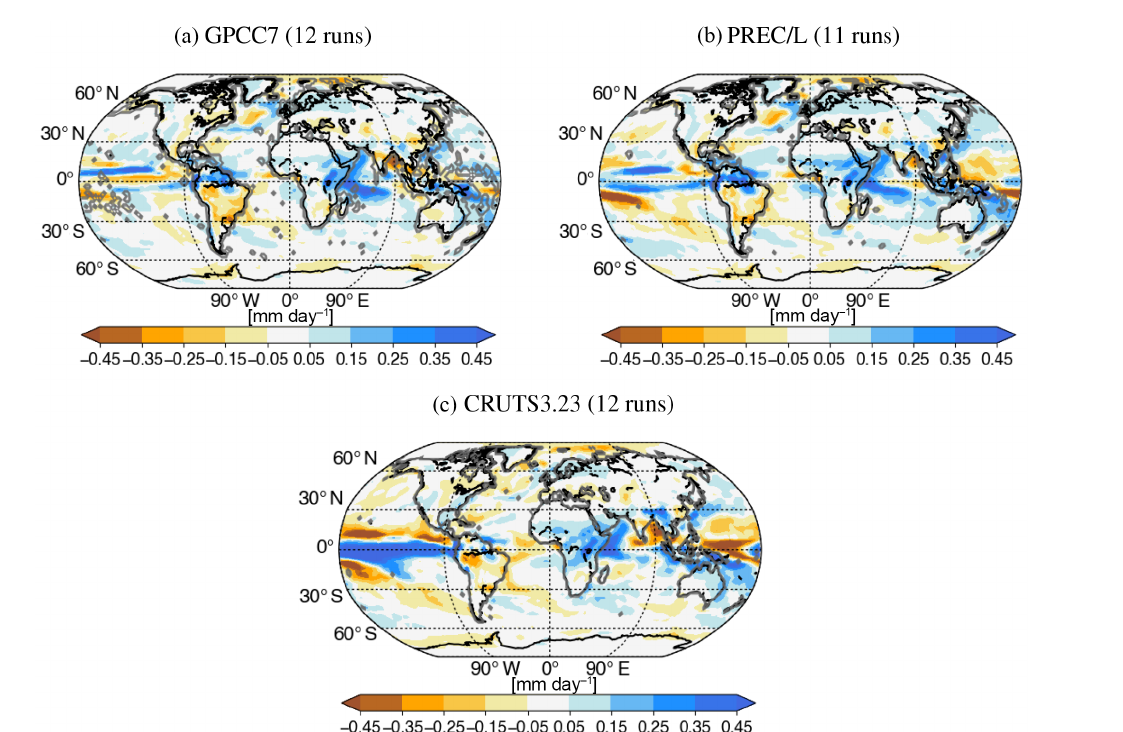
Figure 8. Same as Fig. 7, but for precipitation